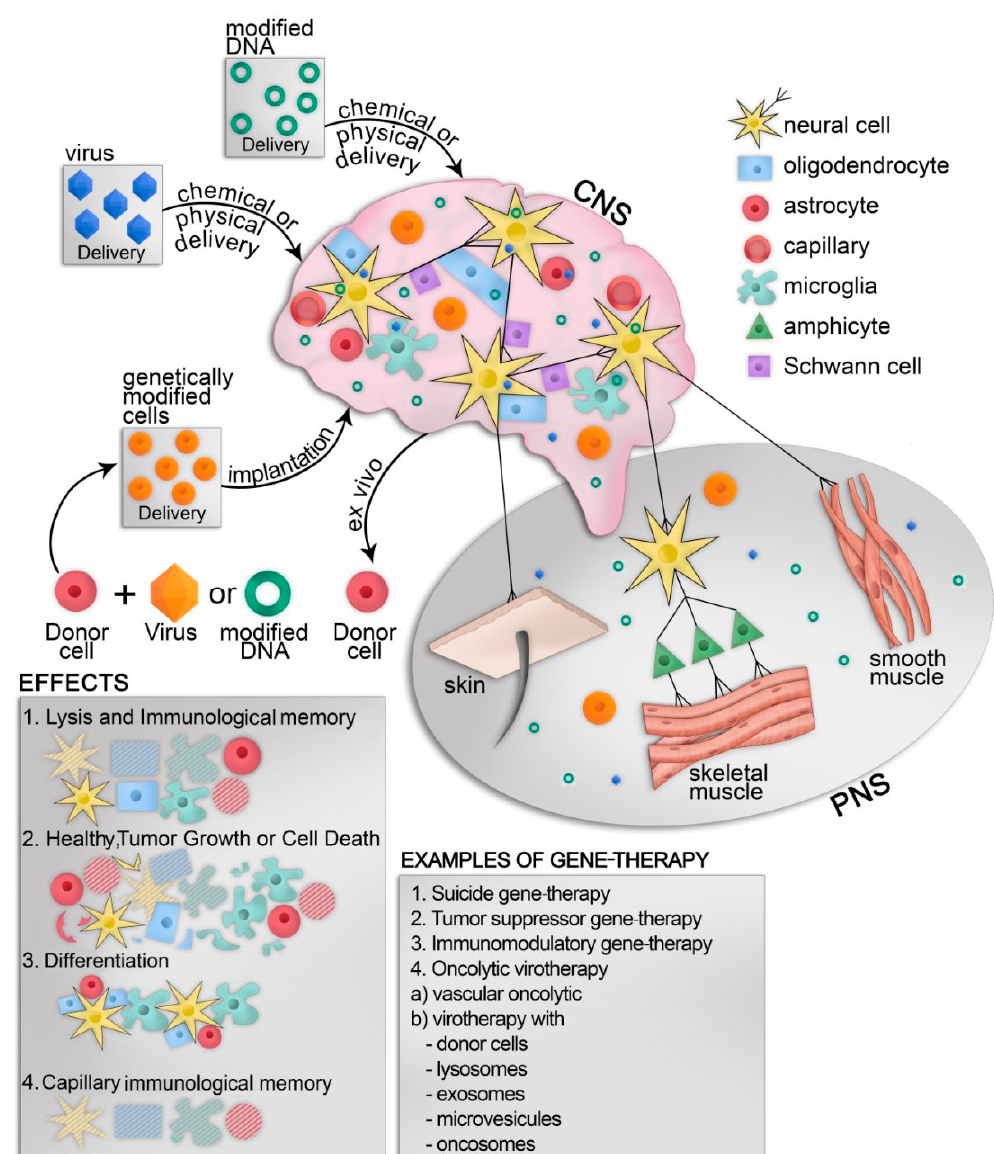
Figure 1. Potential applications of gene targeting for therapy of neurodegenerative diseases.